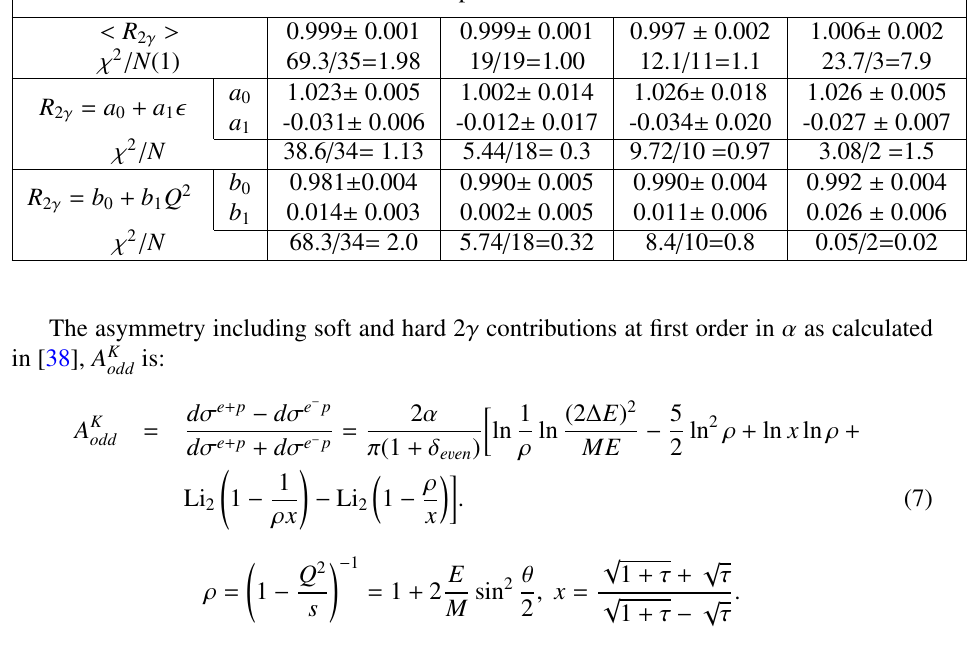
Figure 2. Radiatively corrected ratio of positron to electron cross sections R 2 γ = σ ( e + p ) /σ ( e − p ) with the corresponding linear fits as a function of (cid:15) (left) and Q 2 (right) from OLYMPUS [36] (red circles and red solid line), CLAS [35] (green squares and green dashed line) and VEPP-3 [33] (blue triangles and blue dotted line). The black dash-dotted line corresponds to the global linear fit Table 1. Weighted average of the ratio R 2 γ for all data and for the individual data sets (the OLYMPUS data corresponding to the set (a) of [36]), to be compared to unity for no 2 γ e contribution. The compatibility with a constant R 2 γ = 1 is indicated by χ 2 (1). The results from linear fits in (cid:15) and Q 2 are also given All data OLYMPUS CLAS VEPP